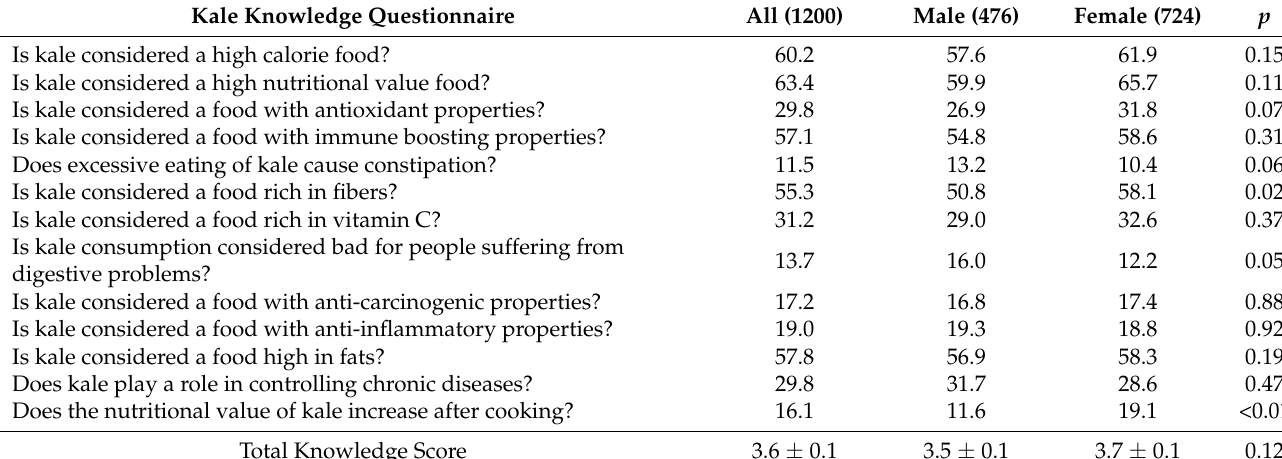
Table 2. Kale knowledge score for the study participants.